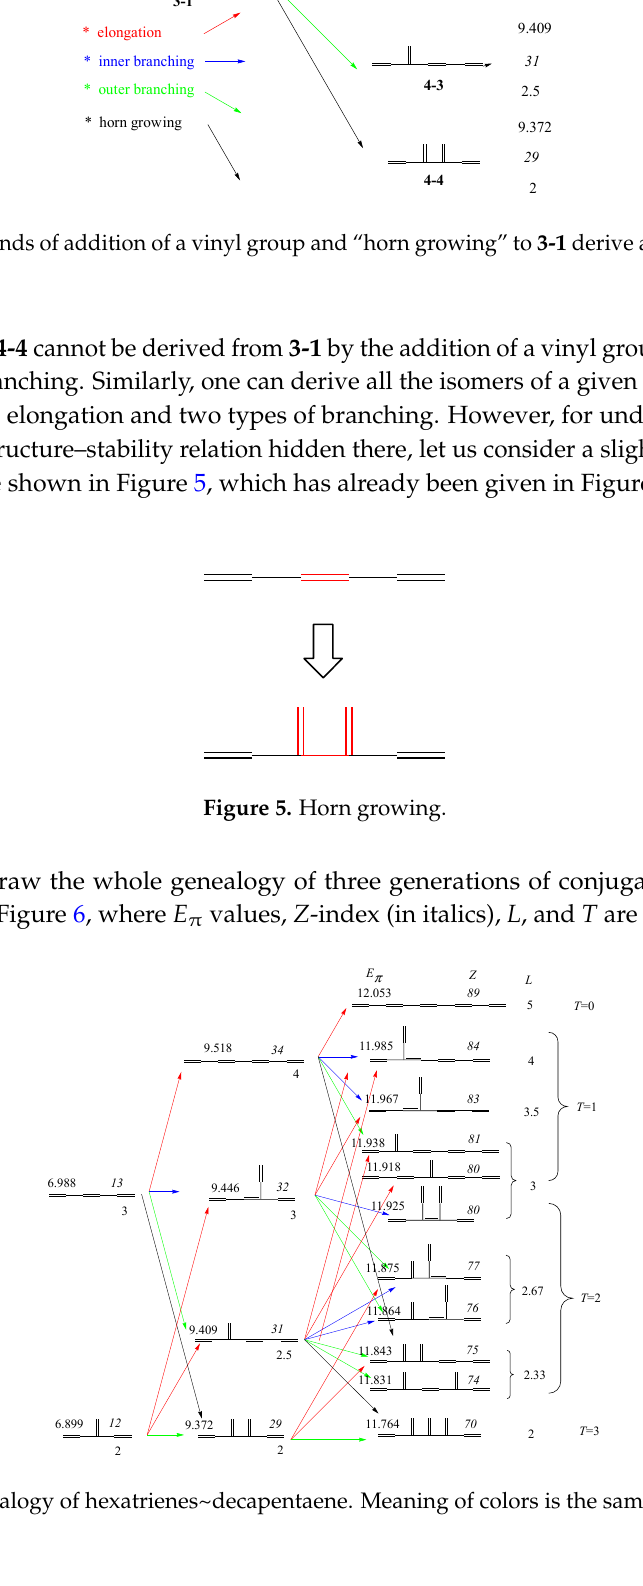
Figure 6. Genealogy of hexatrienes~decapentaene. Meaning of colors is the same as in Figure 4.